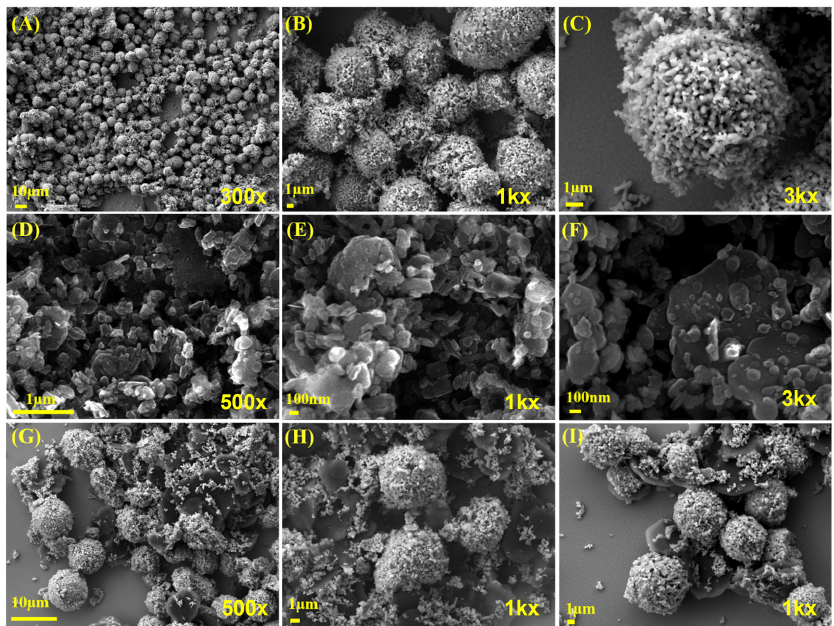
Figure 2. ( A – C ) High (1k× and 3k×) and low (300× and 500×) magnification of FE-SEM image of SrMnO 3 ; examples of ( D – F ) f -BN and ( G – I ) SrMnO 3 / f -BN composite.